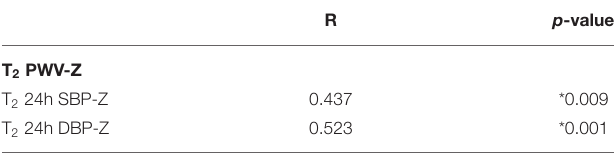
TABLE 5B | Correlation between T 2 PWV-Z and T 2 ABPM.